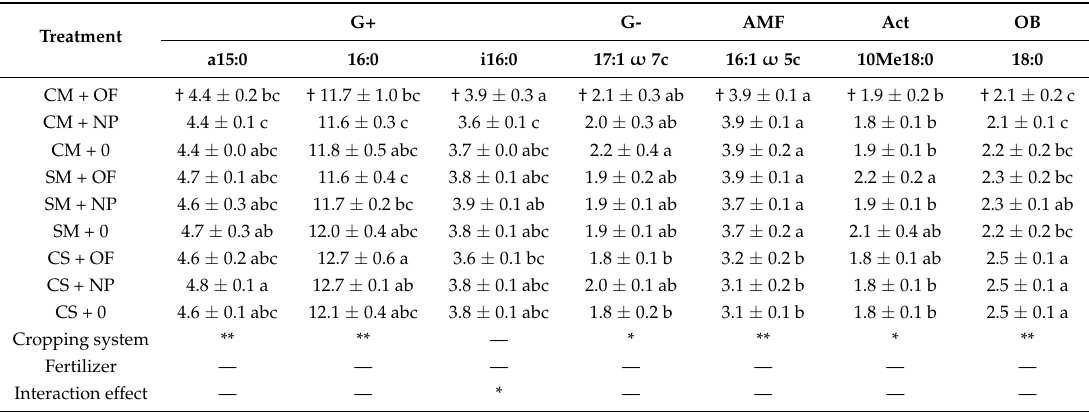
Table 3. The percentage of phospholipid fatty acids under different treatments in soil (%). Values are the average ± 1 standard